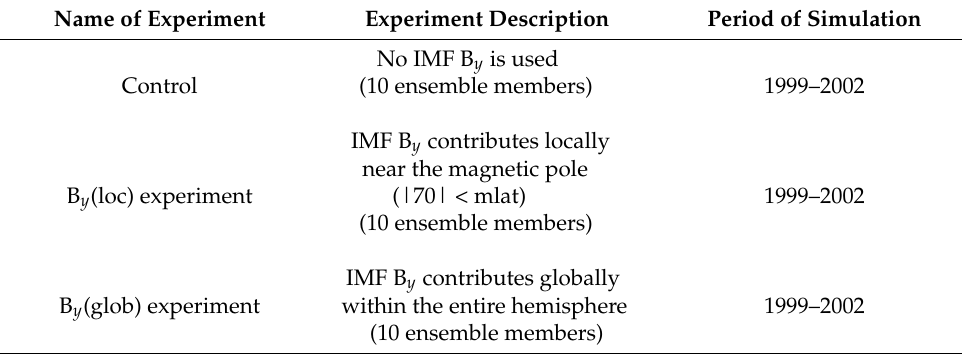
Table 1. The setup of model